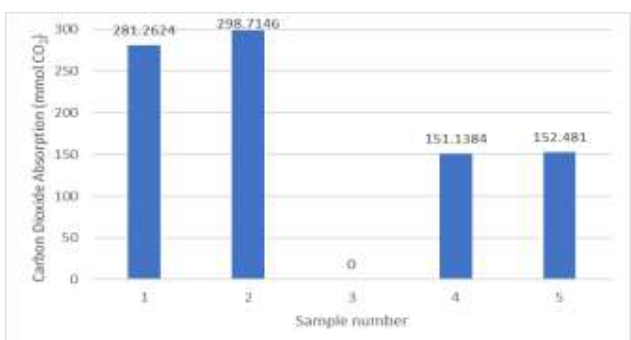
Figure 5: Percentage of CO 2 absorption using different emulsion formulation Based on Figure 5, using MDEA/AMP as extractant (Sample 1), the emulsion absorbed 281.26 mmol CO 2 , while emulsion containing MDEA as extractant (Sample 2) absorbed 296.71 mmol CO 2 . This is due to different formulation of aqueous phase used in the emulsion. The absorption of CO 2 using DOPC as surfactant shows no CO 2 removal because demulsification has occurred. DOPC itself cannot retained the emulsion, thus leads to breakdowns of emulsion. Due to this breakdown, the separation process cannot take place as no medium for diffusion of CO 2 to occur in the solution [5]. A cosurfactant that was introduced in this study formed an adhesive emulsion which lead highly stable emulsion. As shown in Figure 5, CO 2 absorption for Sample 4 was only at 151.14 mmol of CO 2 which is slightly lower than Sample 5. (152.48 mmol of CO 2 ) The differences of absorption capacity are influenced by stability and viscosity of the emulsion.